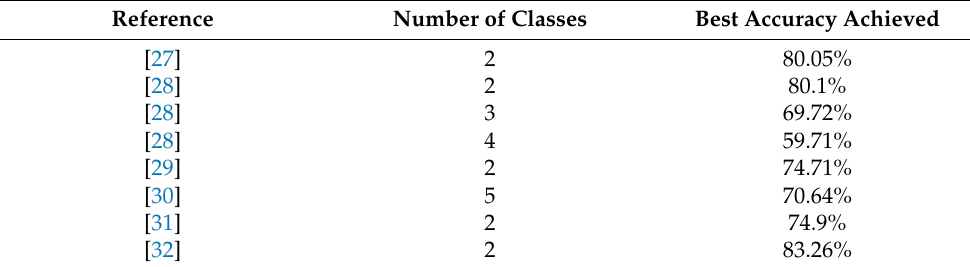
Table 2. Previous results on the PhysioNet database.